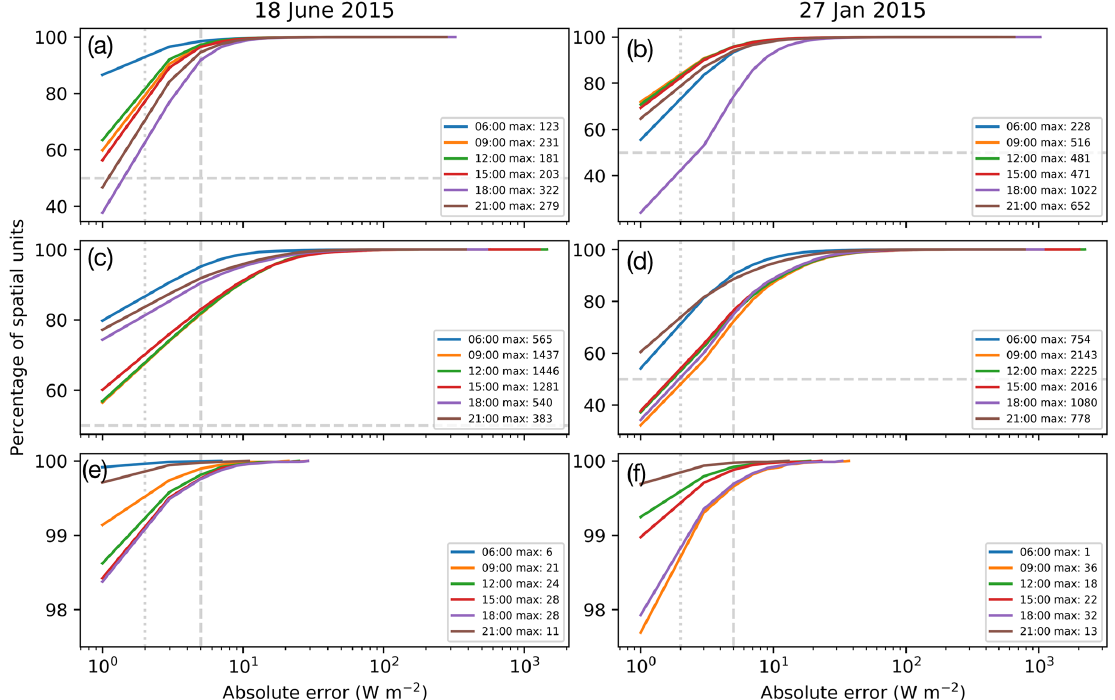
Figure 9. Ranked cumulative frequency of spatial AE i (Eq. 20b) with 2 and 5Wm − 2 (vertical lines) and maximum (key;Wm − 2 ) indicated at six times (colour) for R6 (Table 6, Fig. 8) in 2015 on (a, c, e ) 18 June 2015, (b, d, f ) 27 January 2015, for (a, b ) total domestic Q F, B (c, d ) total commercial Q F, B , and (e, f ) total transport Q F, T . Note y axes are different between rows (50% of spatial units shown by horizontal dashed line if applicable) and x axes are log 10